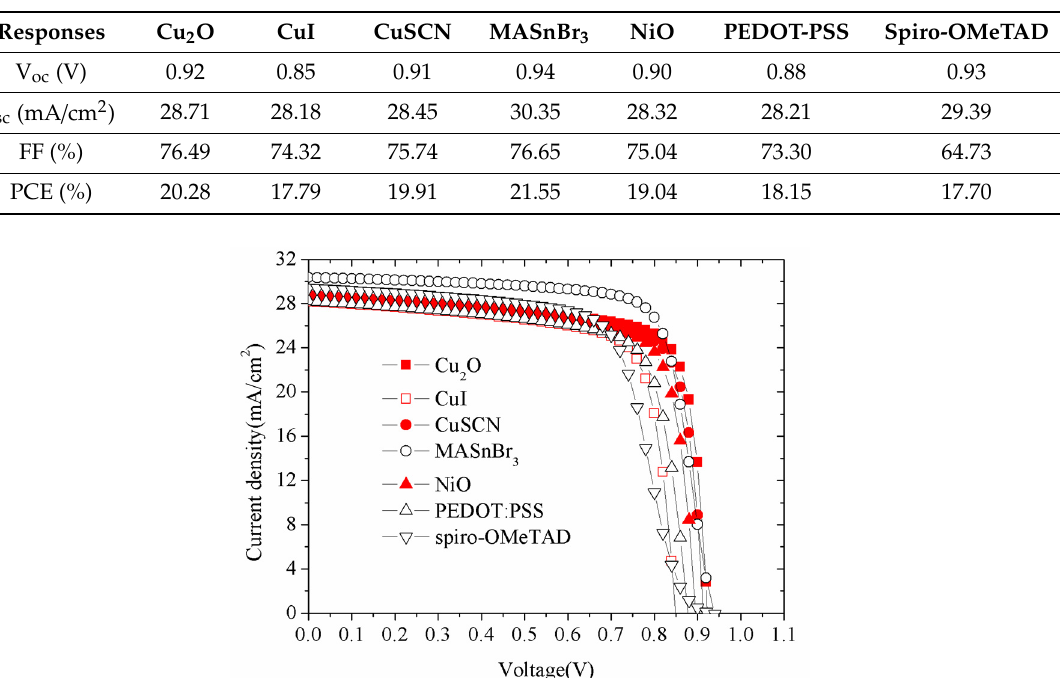
Table 5. Responses of PSCs with di ff erent HTL materials.